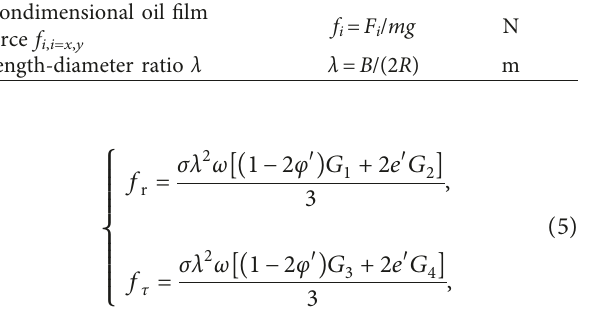
Nondimensional Sommerfeld Nondimensional speed Nondimensional oil